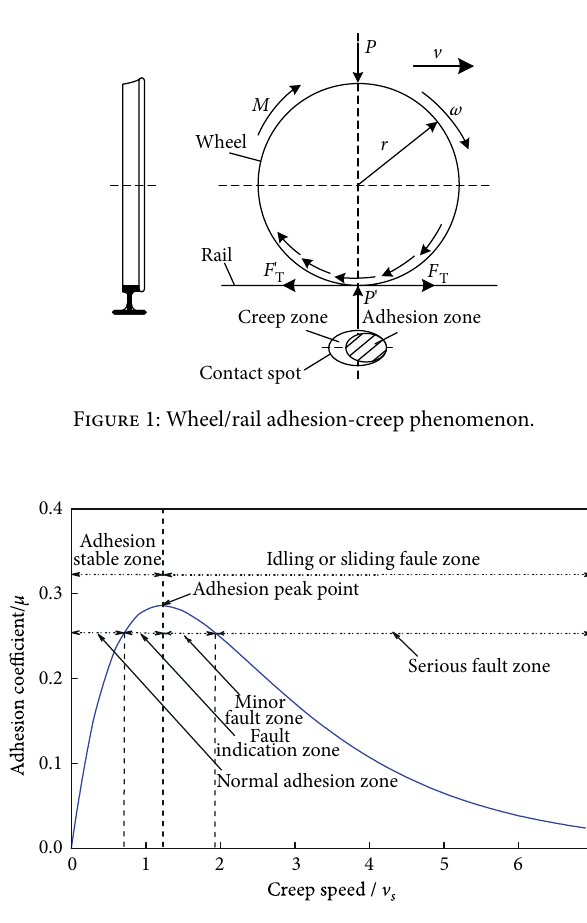
Figure 2: Wheel/rail adhesion-creep changing